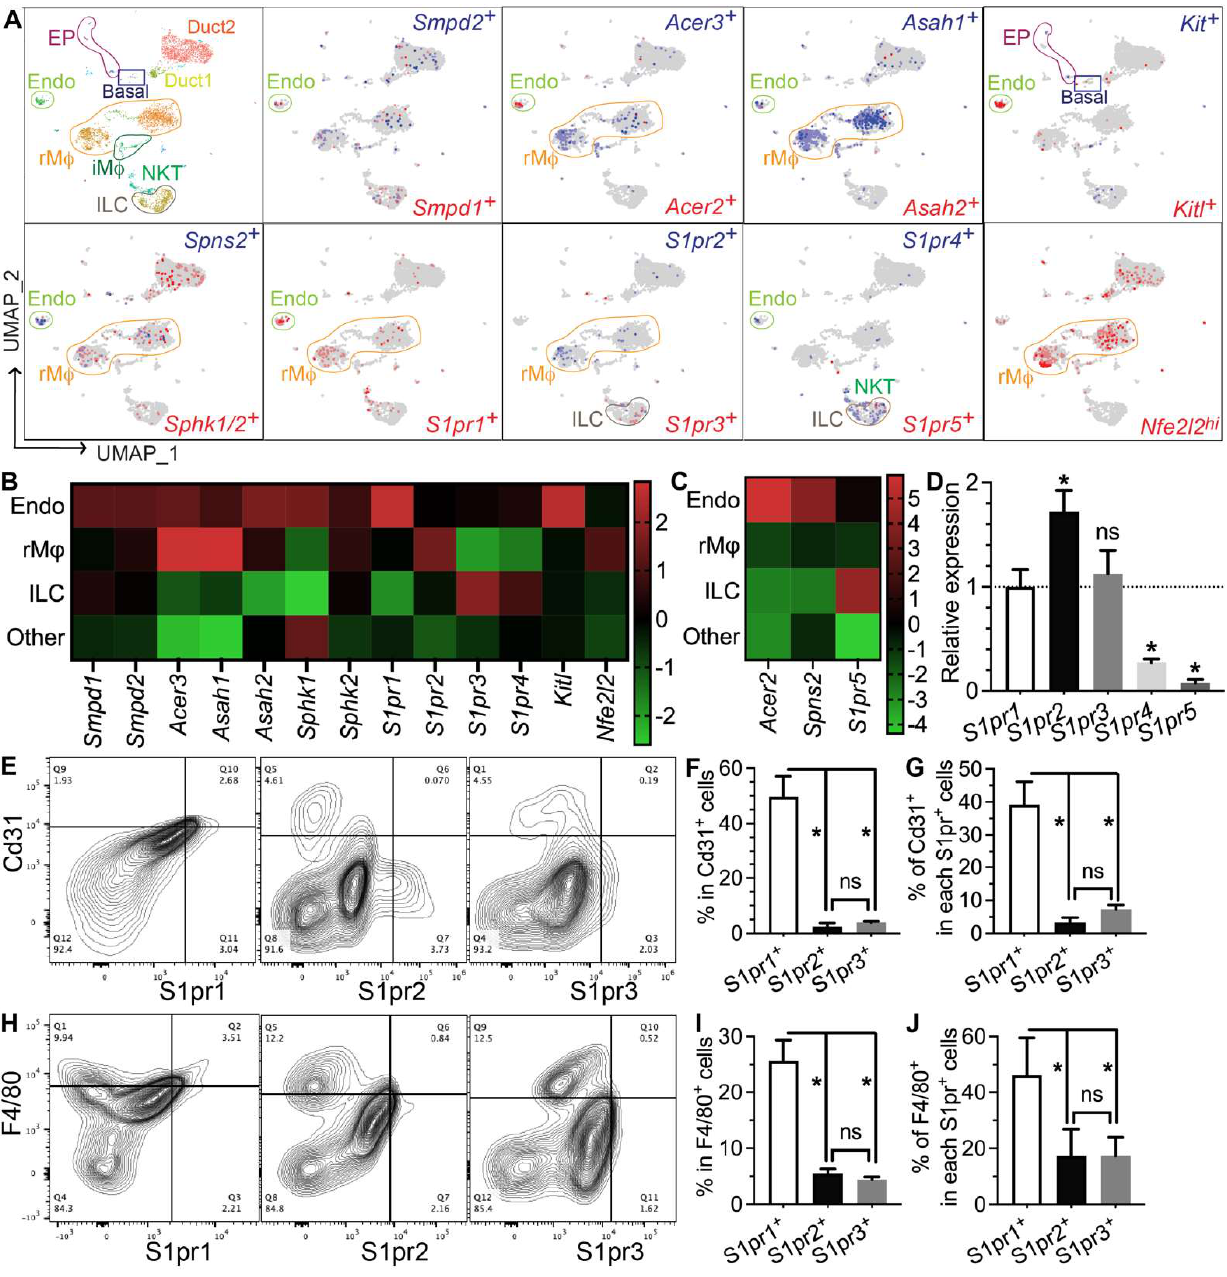
Figure 4. Expression patterns of S1P metabolic genes and receptors in salivary glands. ( A – C ) Expression pattern and relative levels of genes essential for S1P production and secretion, S1P recep- tors, and potential target genes of S1P signaling were shown in the feature plots ( A ) and heatmaps ( B , C ) of scRNA-seq data of nontreated SMGs. Endo: endothelial and peri-endothelial cells; rMφ: resident macrophages; iMφ: infiltrating macrophages; Epi: epithelial cells; ILC: innate lymphoid cells; NKT: natural killer T cells. The color scales in ( B , C ) are log2 fold changes vs. all other clusters. ( D ) mRNA levels of S1P receptors in nontreated SMGs were examined with RT-qPCR and shown as relative to S1pr1 . N = 3. *: p < 0.05 vs. S1pr1 ; ns: not significant vs. S1pr1 . ( E – J ) Expression patterns of major S1P receptors in SMG endothelial cells and macrophages were confirmed with flow cytom- etry. N = 3. *: p < 0.05, ns: not significant. Quantitative data were analyzed using one-way ANOVA with Tukey’s multiple comparisons.